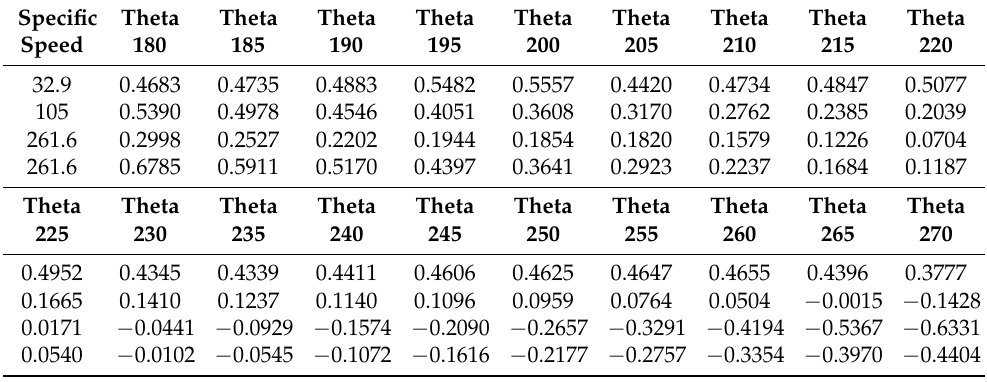
Table 2. Normalized dimensionless head third-quadrant input datasets for test validation.